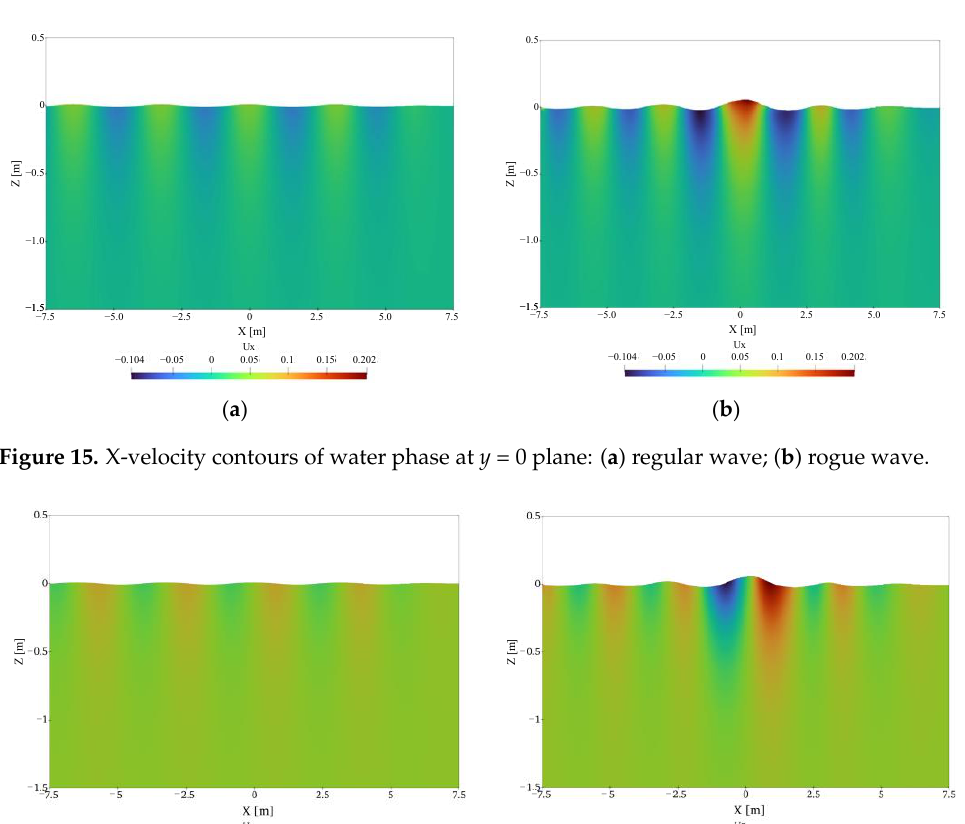
( b ) Figure 14. Pressure contours of water phase at y = 0 plane: ( a ) regular wave; ( b ) rogue wave. The effect of the rogue wave on the velocity of water particles was investigated. Fig-